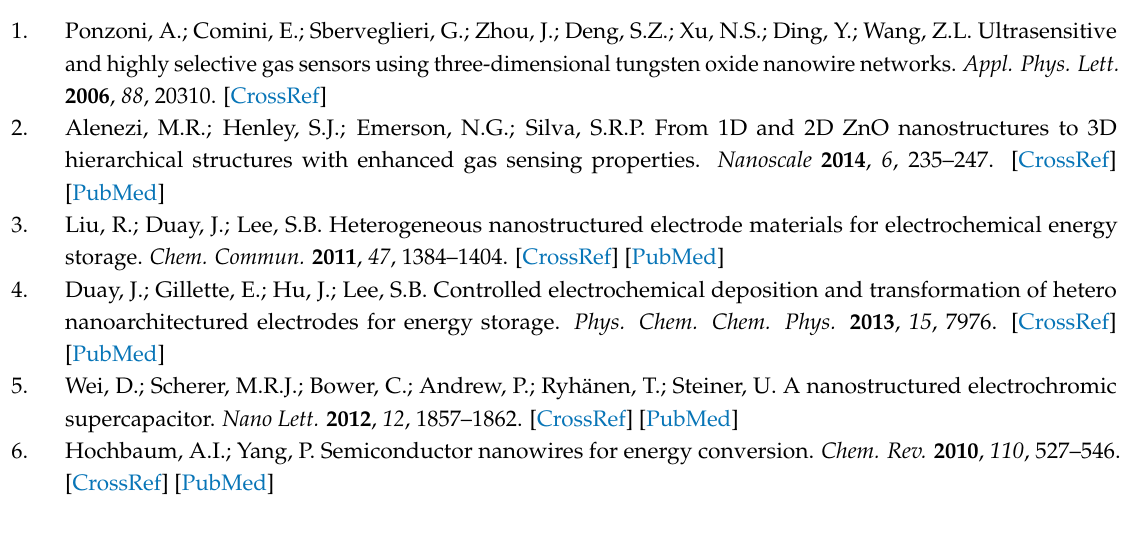
Figure S1: Irradiation through mask to limit the electrodeposition area during growth of interconnected nanowires, Figure S2: Nanowire network with interconnected wires from 5 directions, Figure S3: Photoelectrochemical properties of the TiO 2 layer, Figure S4: ZnO/TiO 2 band